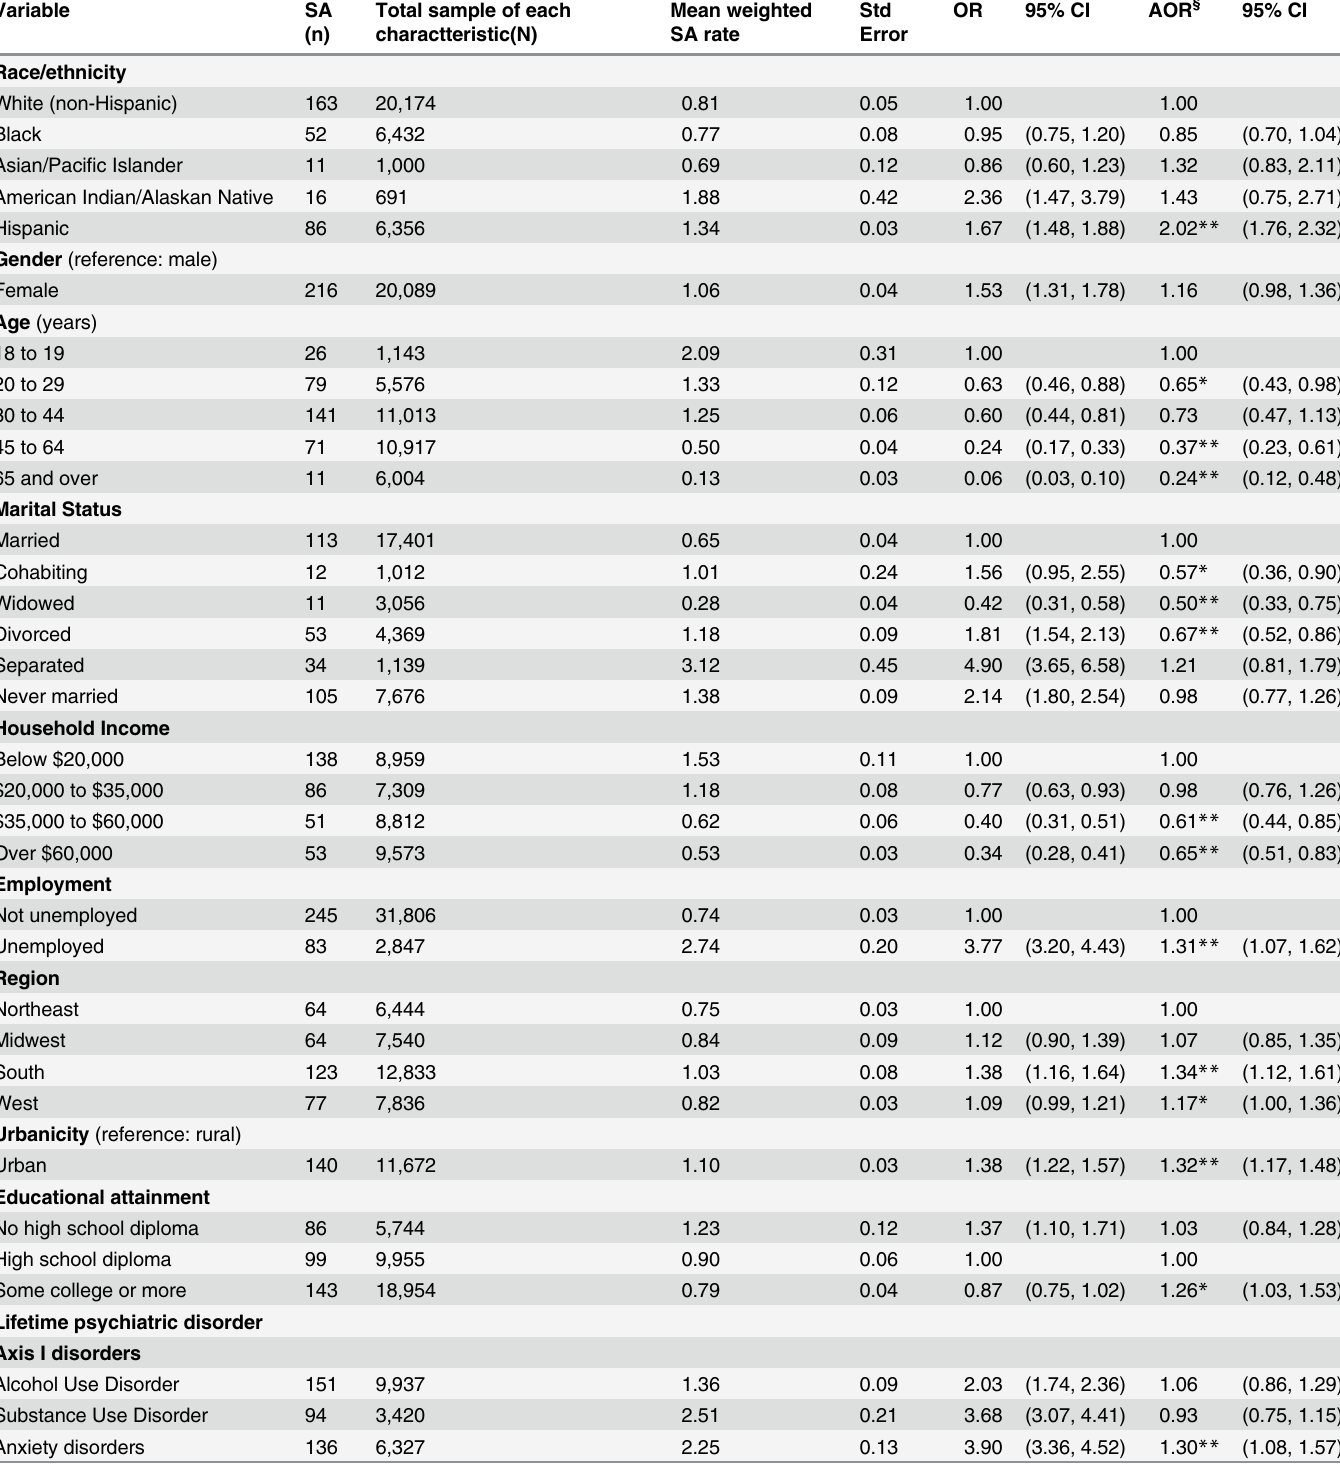
Table 1. Weighted Percentages, Standard Errors, Unadjusted and Adjusted Odds Ratios (OR and AOR) and 95% Confidence Intervals (CI) of Sui- cide Attempts (SA) Occurred Between Wave 1 and 2 (mean: 3.1 years) by Wave 1 Characteristics.